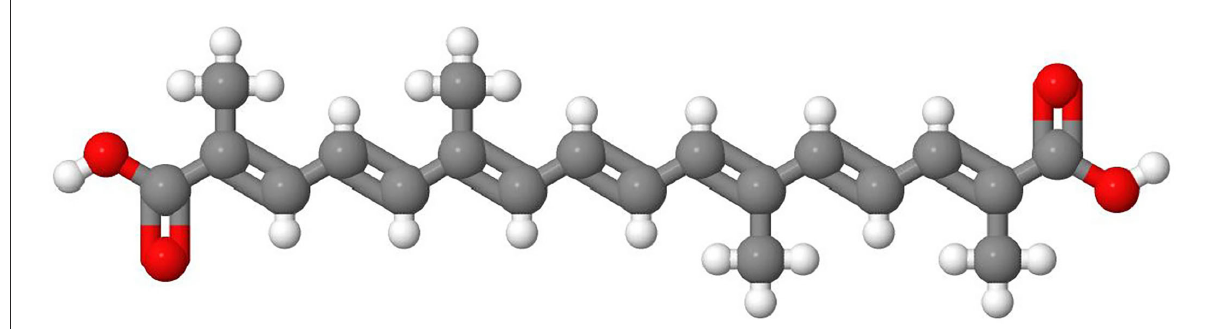
FIGURE1 Crocetin, the major active component of saffron. Crocetin (C 20 H 24 O 4 ; MW: 328.40 g/mol) is a dicarboxylic acid containing seven conjugated double bonds, 4 side-chain methyl groups, and carboxylic acid groups at both ends. It is a potent antioxidant supposed to be therapeutically effective in many disorders. The chemical structure of transcrocetin (8,8 ′ -Diapocarotenedioic acid, CAS 27876-94-4) depicted here was taken from the PubChem database (CID: